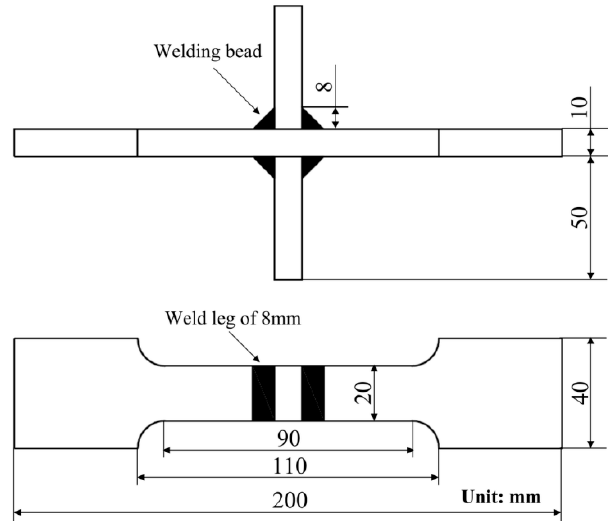
Figure 1. The geometrical characteristics of the fatigue specimens. Table 1. The mechanical properties of Q345 steel.